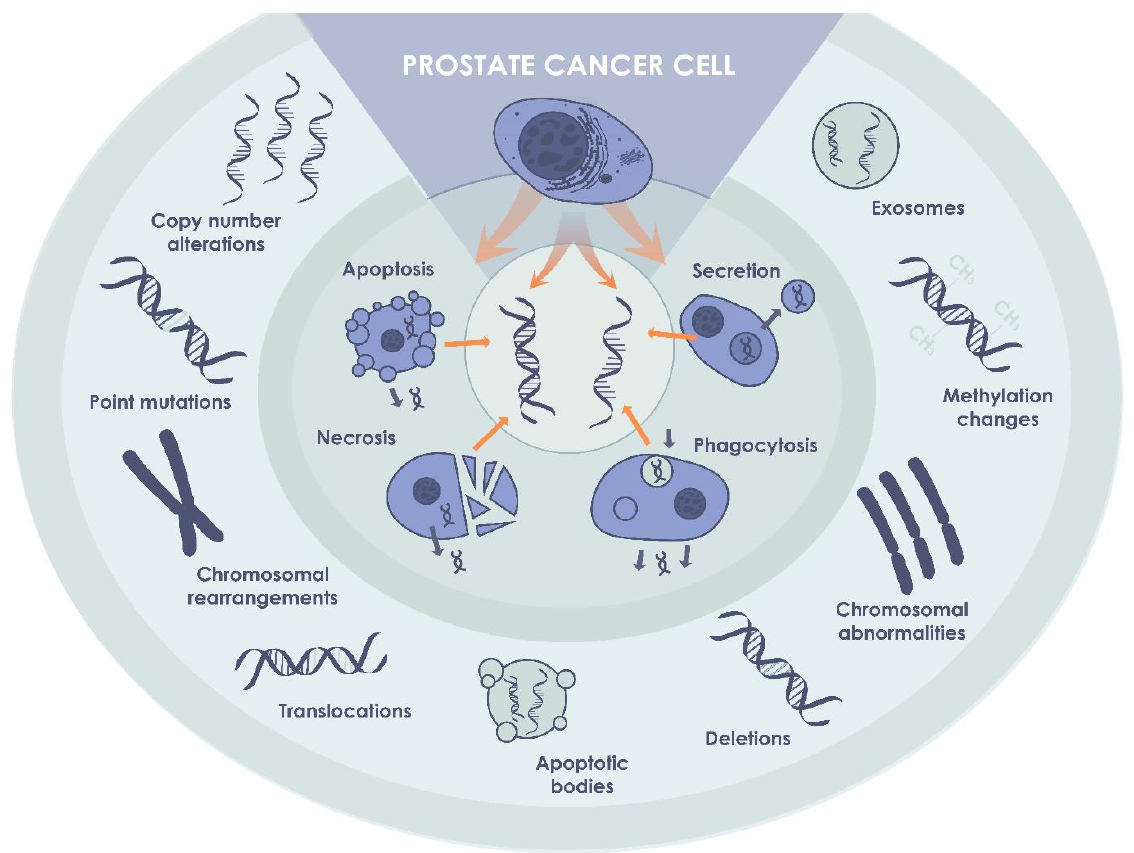
Figure 2. ctDNA in PCa. ctDNA, originating from cancer cells, may be detected in biological fluids of patients with non-metastatic PCa, and can be used as a biomarker of the disease.